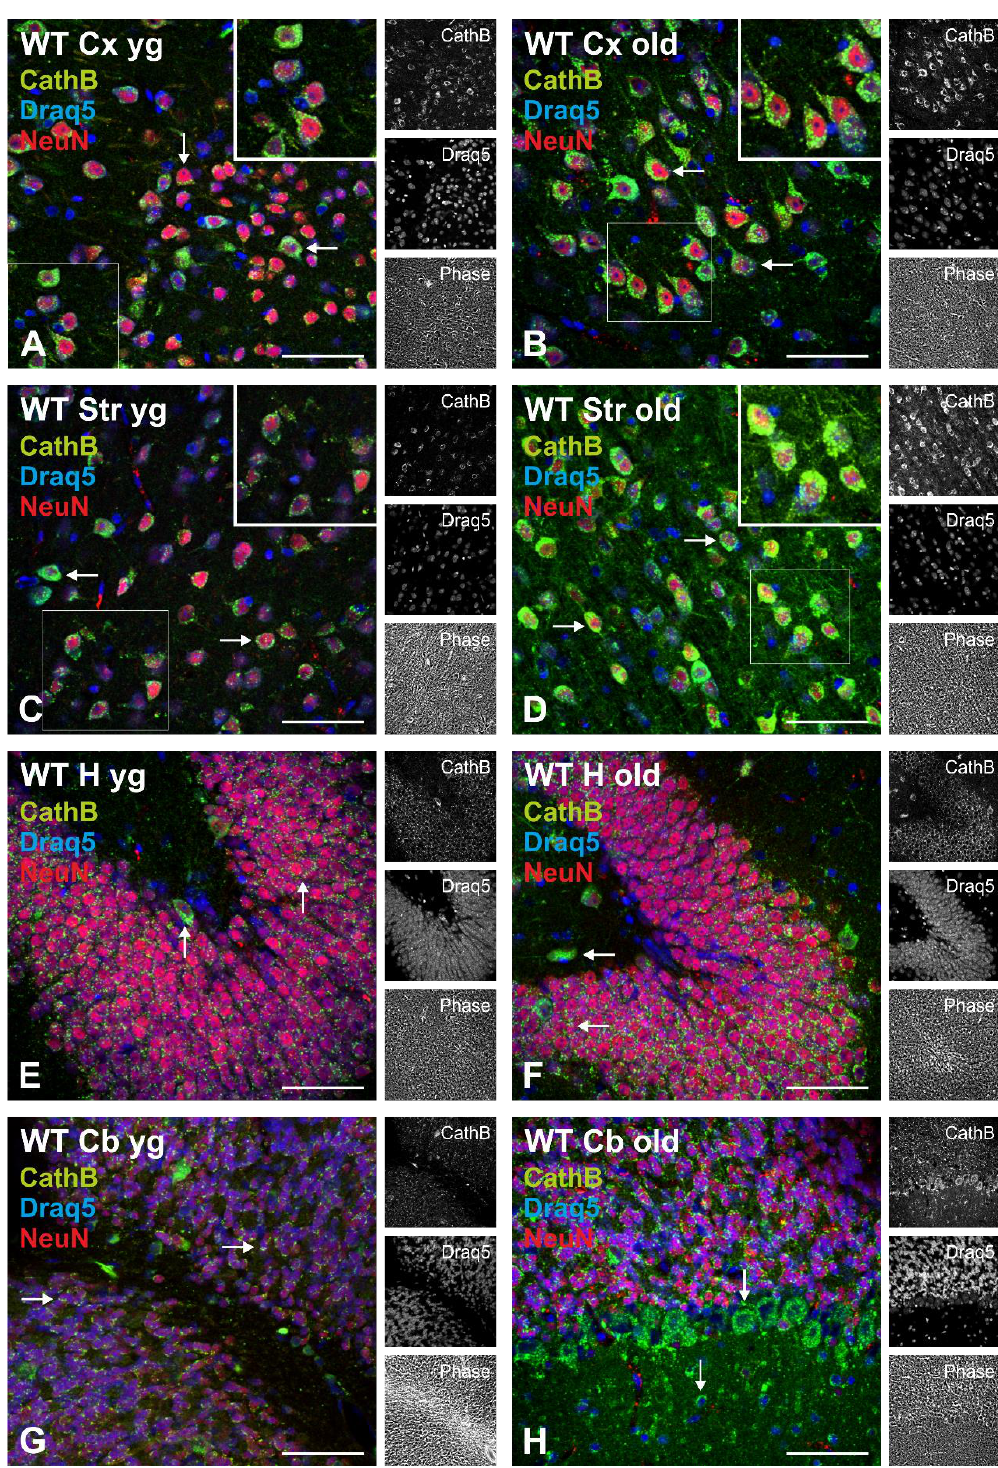
Figure 1. Distribution and localization of cathepsin B in the CNS of young and aged WT mice. ( A – H ) Cathepsin B localization in CNS of WT young ( A , C , E , G , 5 – 7 months old) and aged ( B , D , F , H , 18 – 20 months old) mice using confocal scanning microscopy ( green, cathepsin B; blue, Draq5™ nuclear stain; red, NeuN neuronal marker). Boxed areas in ( A – D ) are magnified in the respective inserts (top right). Cathepsin B was localized in a vesicular pattern (arrows) in neuronal cells and other brain cells in cortex ( A , B ), striatum ( C , D ), hippocampus ( E , F ), and cerebellum ( G , H ). Scale bars: 50 µ